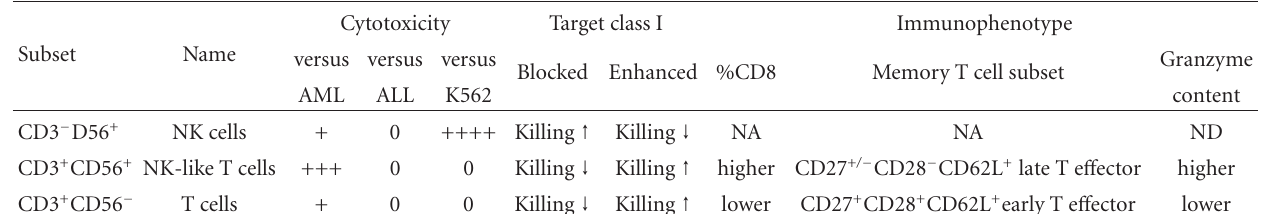
Table 1: Comparison of the three subsets of cells in a CIK culture. NA = not applicable, ND = not done.